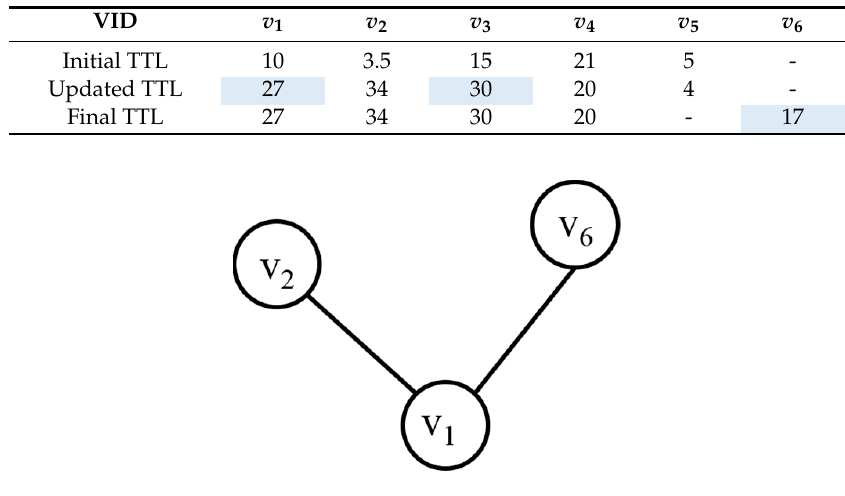
Table 2. Example of UC replacement.